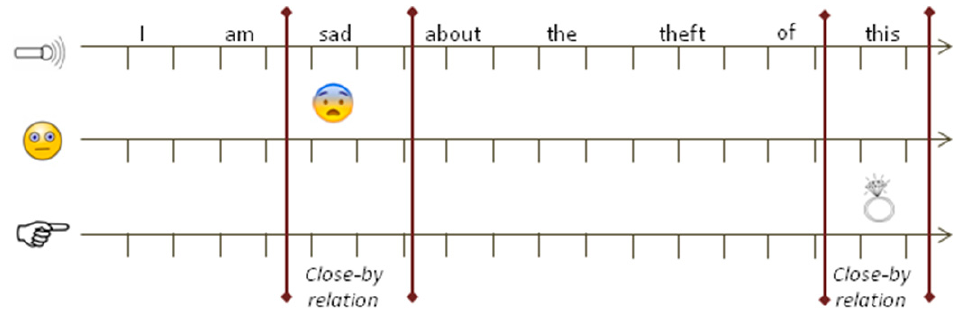
Figure 1. Example of an ambiguous multimodal sentence.